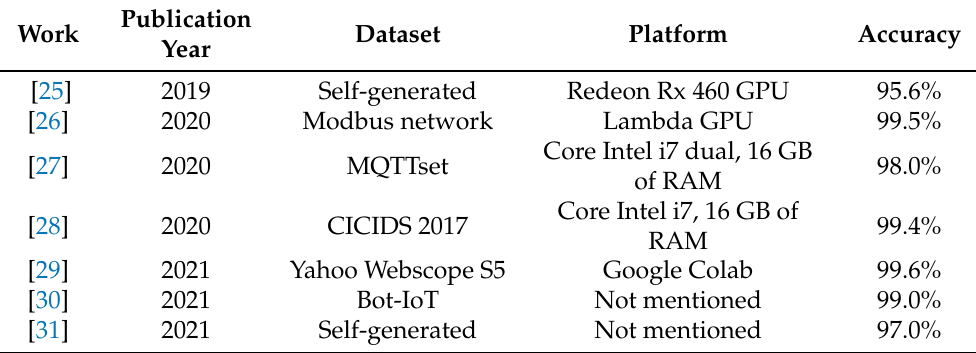
Table 1. Summary of anomaly-based IDS for IoT